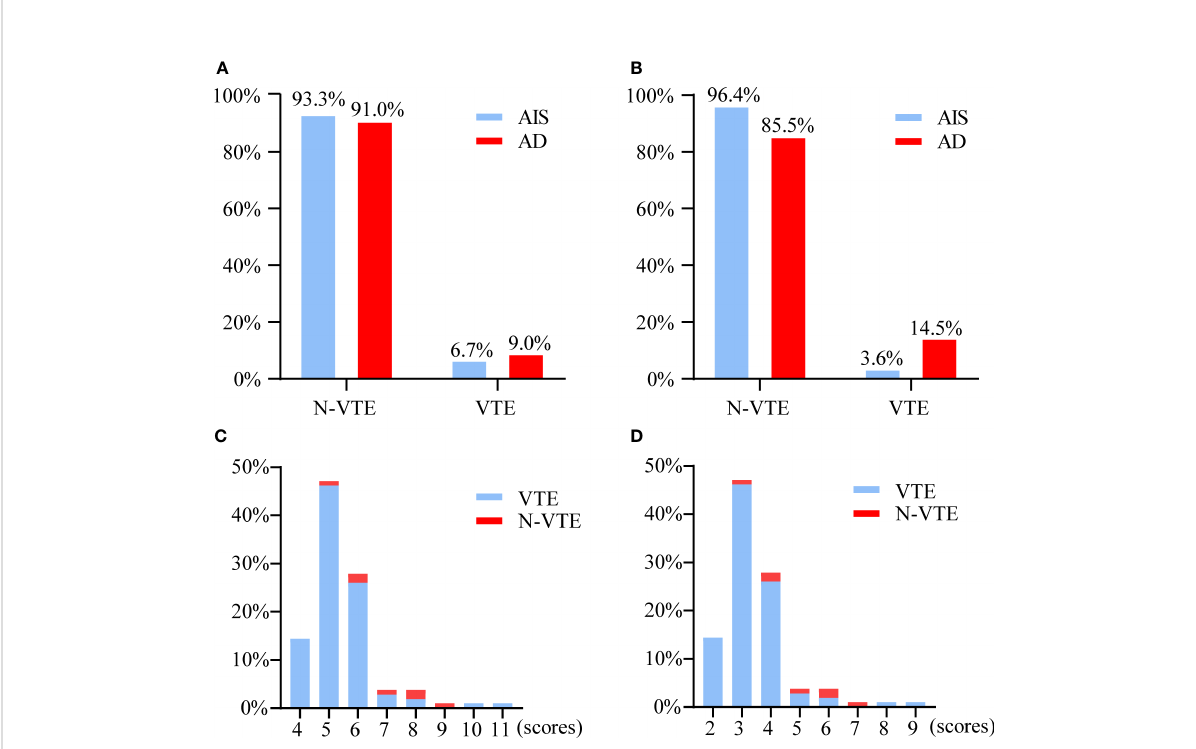
FIGURE 2 (A) Proportion of VTE and N-VTE patients between AIS and AD groups before PSM. (B) Proportion of VTE and N-VTE patients between AIS and AD groups after PSM. (C) Distribution of Caprini scores in patients with AIS while remaining the “ malignant tumor ” item. (D) Distribution of Caprini scores in patients with AIS while removing the “ malignant tumor ” item. VTE, venous thromboembolism. AIS, adenocarcinoma in situ.PSM, propensity score matching. AD,